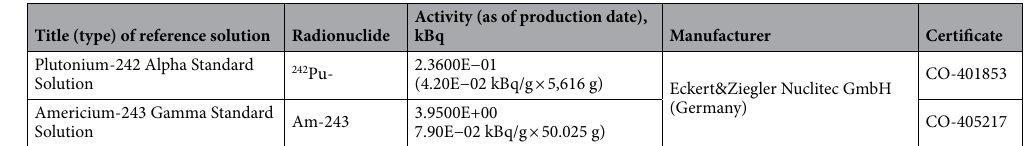
Activity (as of production date),